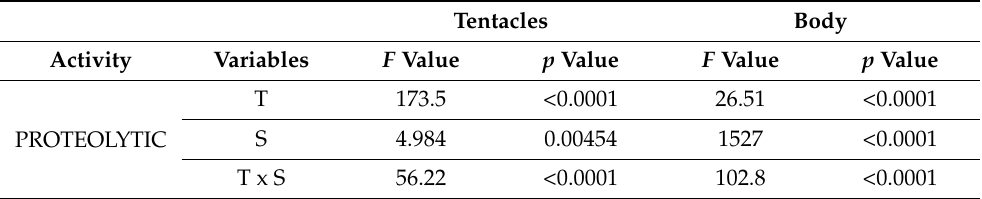
Table 2. Two-way ANOVA analysis results of Proteolytic activities (Fibrinolytic and Gelanolytic) measured in the tentacles and body extracts of A. viridis . Statistically significant effects were seen in the following variables—Time (T) and Substrate (S) and interactions (TxS). Bold numbers indicate the significant p -value. The analyses were carried out using the GraphPad Prism Version 8.0.0. for Windows (www.graphpad.com (accessed on 1 March 2021)). Differences between means were considered significant for p < 0.05.